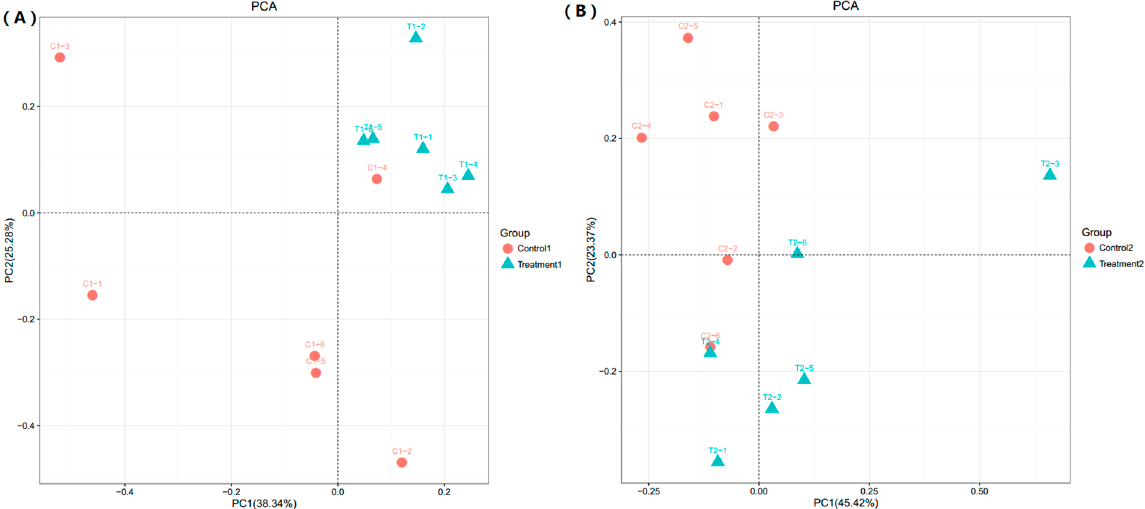
Figure 3. Principal components analysis (PCA) plots of samples from different days and groups: 21 ( A ) and 42 ( B ) days. Red dot means control group and blue dot means lecithin treatment group.